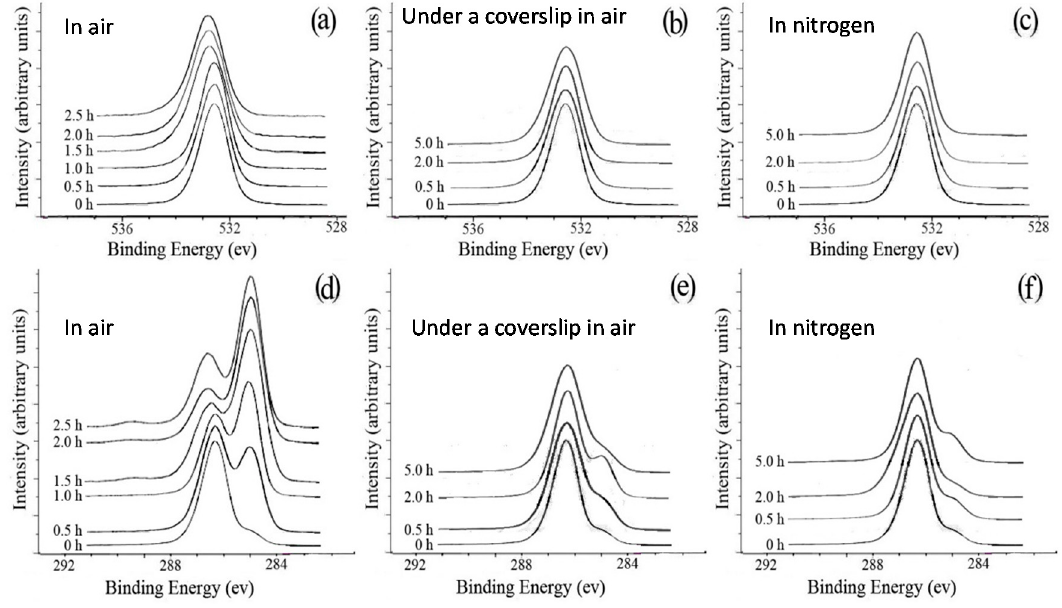
Figure 8. O1s spectra ( a – c ) and C1s spectra ( d – f ) of the original PEO films and PEO films annealed at 125 °C for up to 5 h: ( a , d ) without a coverslip in air; ( b , e ) with a coverslip in air; ( c , f ) without a coverslip in nitrogen [42].